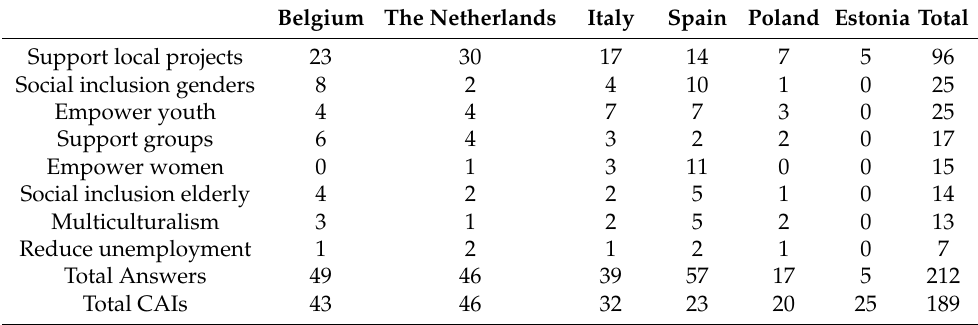
Table 11. Main Social